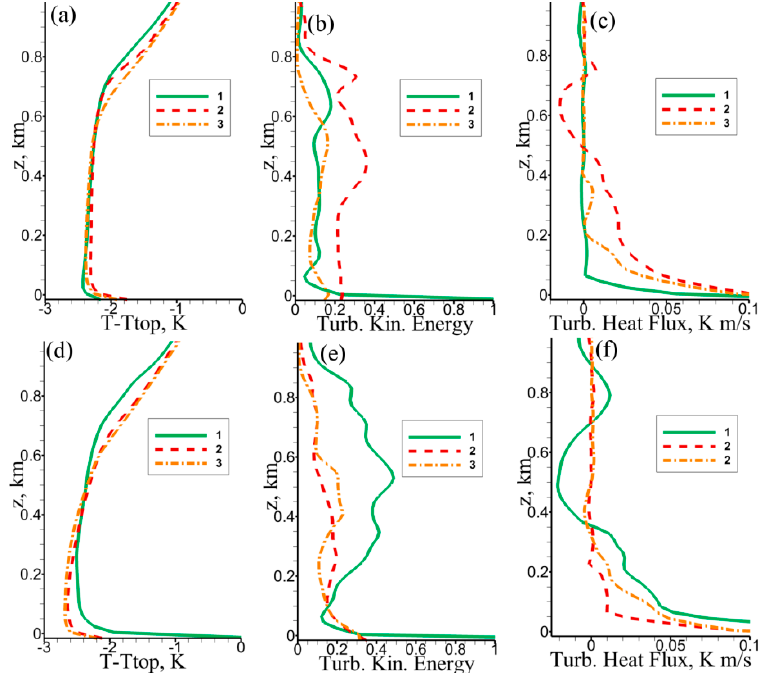
Figure 11. Vertical profiles, averaged over the cross-sections (along the lines 1, 2, 3 indicated in Figure 2a), at different diurnal phases. ( a , d ) Temperature; ( b , e ) Turbulence kinetic energy; ( c , f ) Vertical turbulent heat flux; ( a – c ) Summer case; ( d – f ) Winter case.